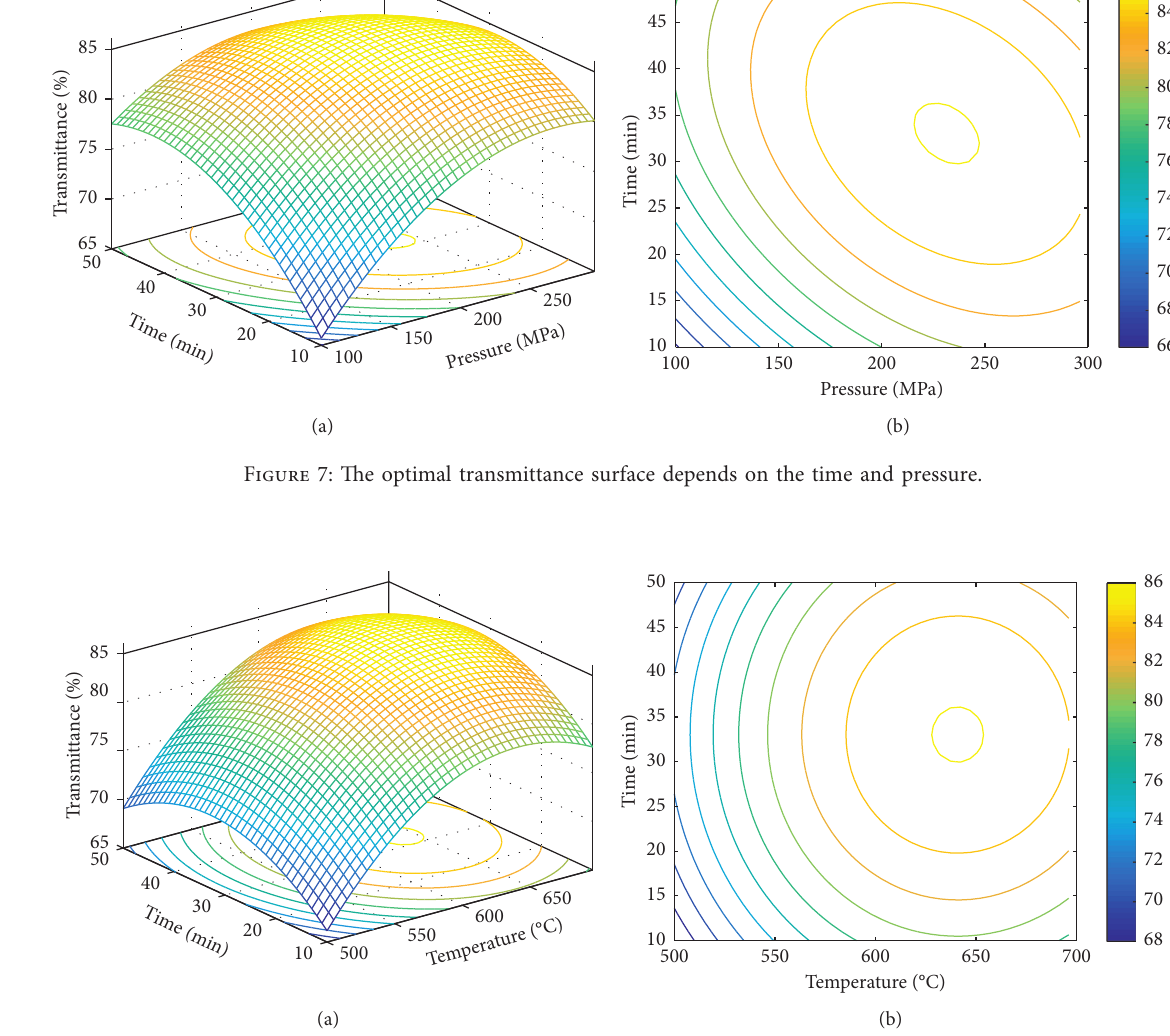
Figure 8: The optimal transmittance surface depends on the temperature and